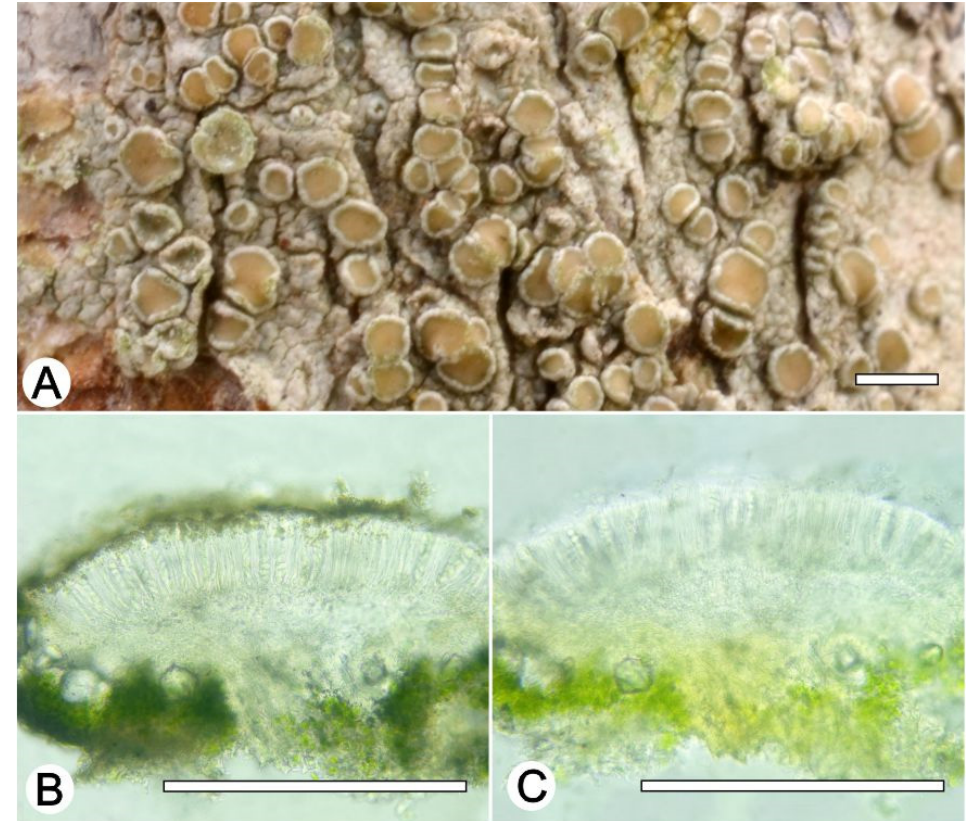
Figure 10. Lecanora pallidachroa sp. nov. ( A ) Thallus with ascomata (holotype ISE-54332a); ( B ) Apo- thecial section in water (holotype ISE-54332a; ( C ) Apothecial section after KOH treatment (holotype ISE-54332a). Scale bars: ( A ), 1 mm; ( B , C ), 100